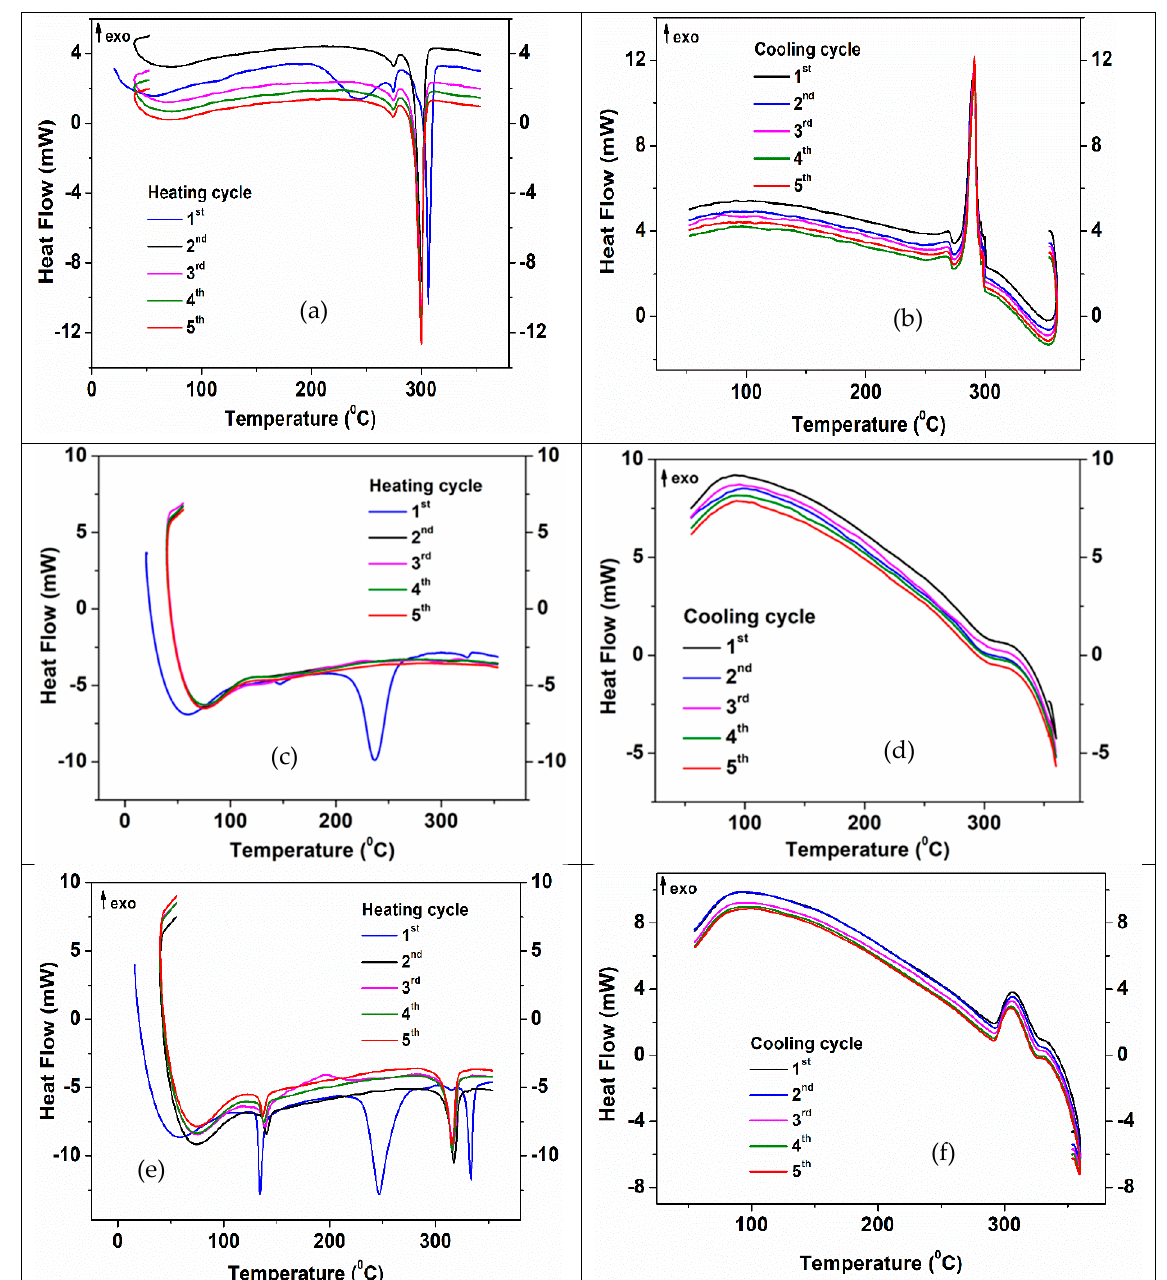
Figure 11. DSC curves for five heating-cooling cycles of the 3D ZnO-CNT structure impregnated with ( a , b ) NaNO 3 ; ( c , d ) KNO 3 ; and ( e , f ) NaNO 3 :KNO 3 .